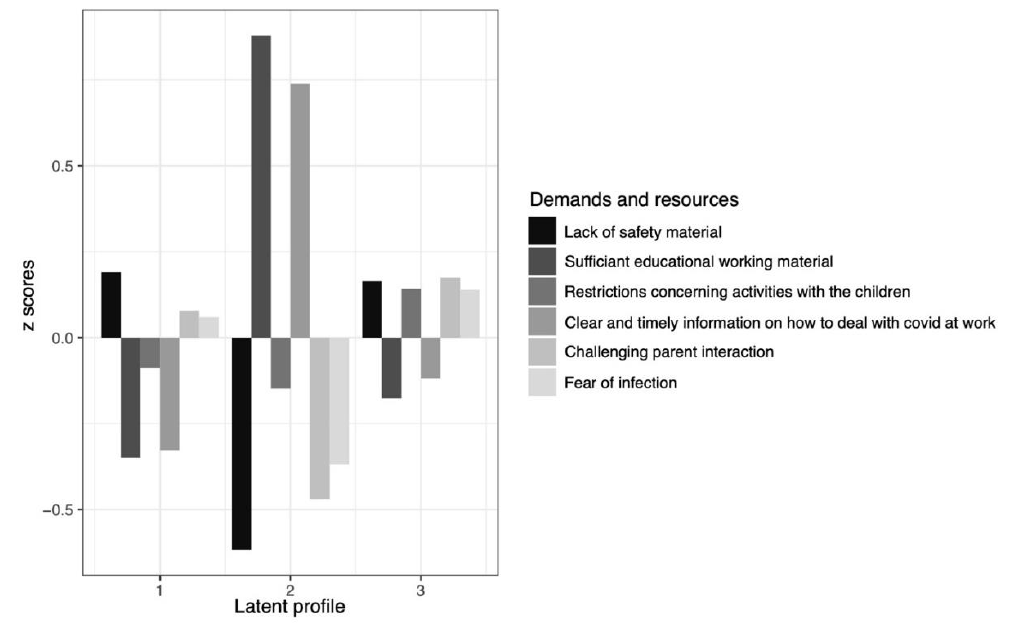
Figure 2. Latent profile solution for demands and resources (z-scores: lack of safety material, sufficient educational working material, restrictions concerning activities with the children, clear and timely information on how to deal with covid at the work, challenging parent interaction and fear of